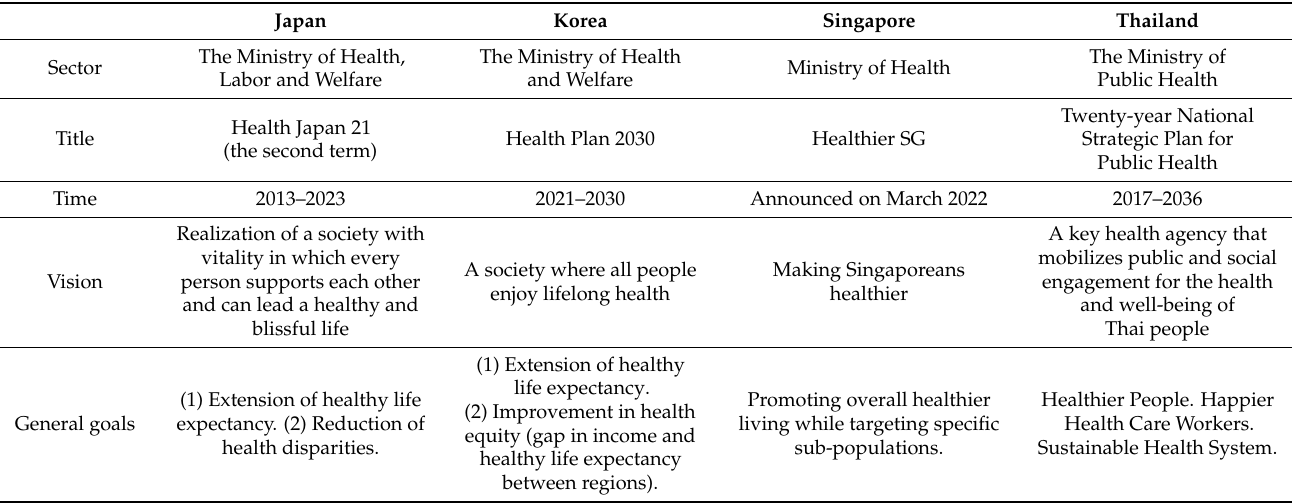
Table 3. Current national health promotion policies of Japan, Korea, Singapore, and